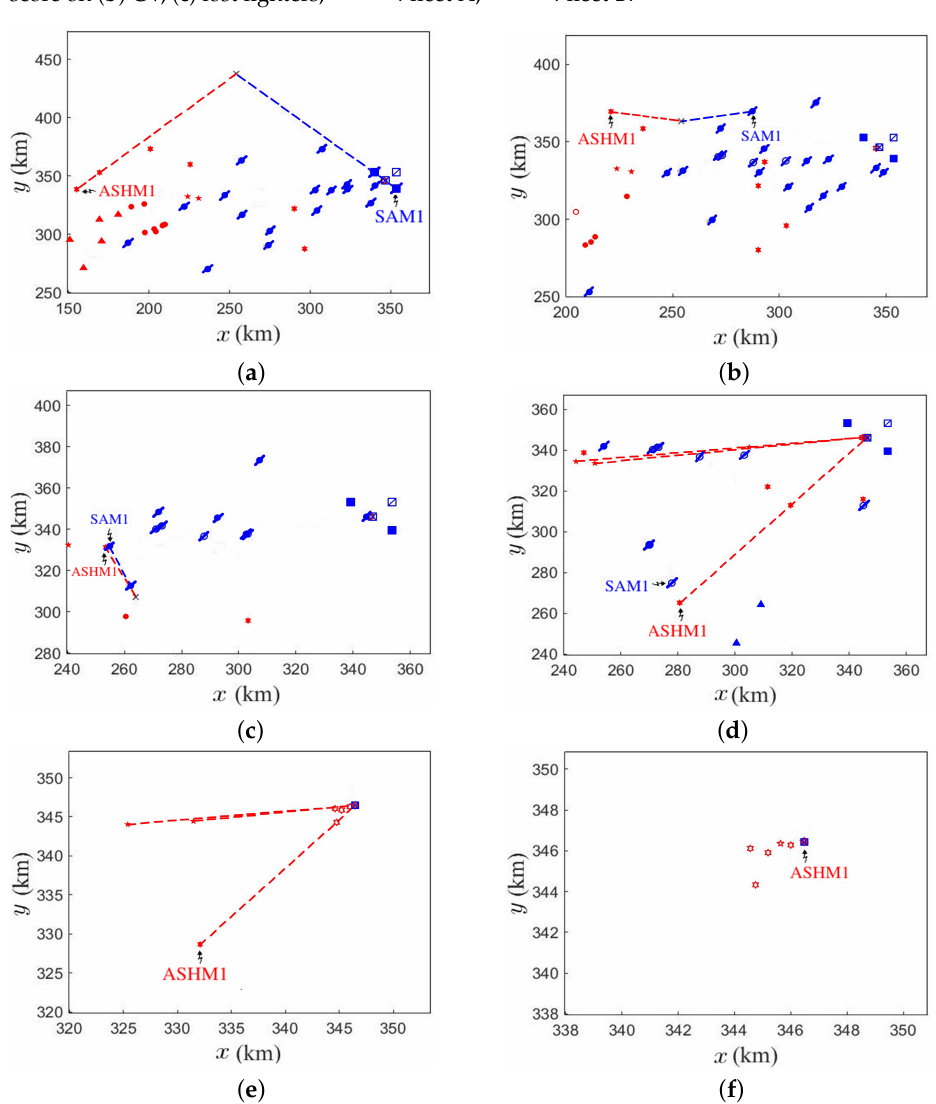
Figure 25. Specific game on A2/B3, an ASHM from CG-A evading a SAM from DDG-B and later attacking CV-B, ( a ) t = 1320 s, ( b ) t = 1440 s, ( c ) t = 1530 s, ( d ) t = 1635 s, ( e ) t = 1755 s, ( f ) t = 1800 s. Symbols are referred to Table